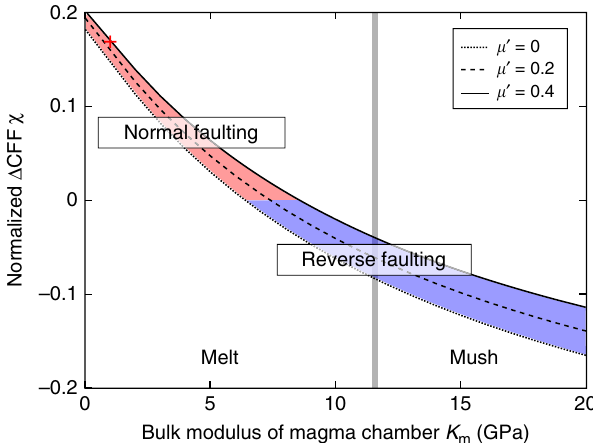
Fig. 4 Properties of the magma chamber deformation system. The vertical axis χ is the average Δ CFS on a 67° dipping normal fault from the tip of the magma chamber to the surface (bold line in Fig. 3b) resulting from an applied vertical tidal stress, normalized by that stress. The red area de fi nes the conditions in which low tides encourage seismicity on normal faults and high tides discourage it, and the blue area vice versa. The plus sign indicates the conditions shown in Fig. earthquakes will be favored by low tides, negative values by high tides and vice versa for thrust earthquakes. All conditions in Fig. 4 within the red region therefore favor normal faulting earthquakes on the low tide and inhibit them on the high tide, and within the blue region, vice versa. Normal faulting may be generated by low tides for values of K m < 8 GPa, depending on the value of µ '. The point indicated by the plus in Fig. 4 is the case illustrated in Fig. 3b. The bulk modulus of gas-free mid-ocean ridge (MOR) magma is 12 GPa 18 , but at the pressure of the magma chamber